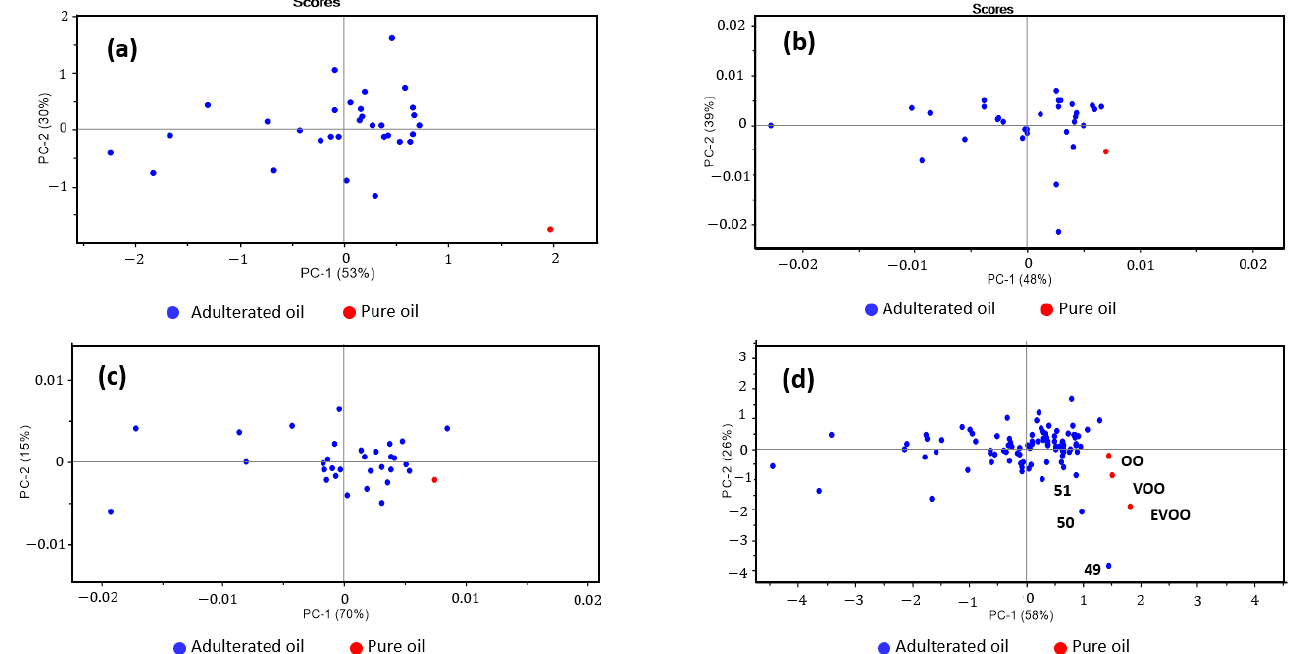
Figure 14. Principal component analysis of three olive oils and their corresponding mixtures: ( a ) extra virgin olive oil (EVOO) and mixtures of EVOO and other seed oils, ( b ) virgin olive oil (VOO) and mixtures of VOO and other seed oils, ( c ) olive oil (OO) and mixtures of OO and other seed oils, and ( b , d ) all the samples pure and adulterated in the sample set. Table 3. Calibration and cross-validation statistics of developed models to quantify adulteration of olive oil with seed oils (N =